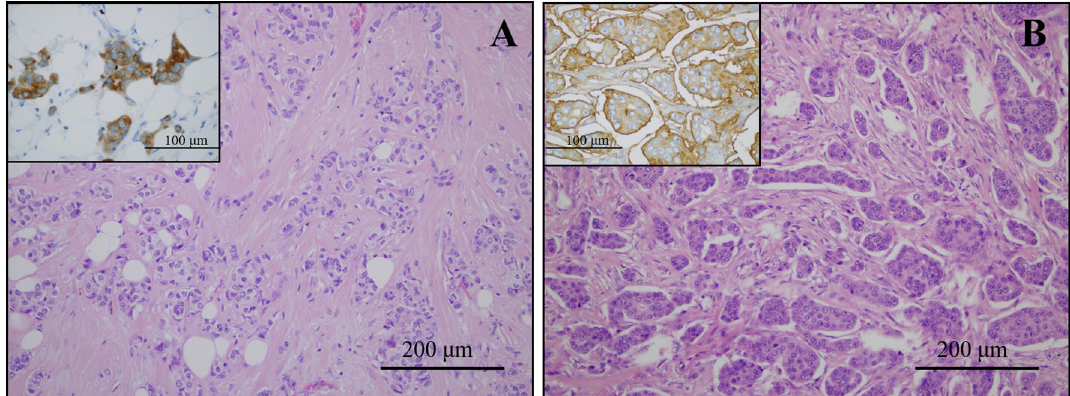
Figure 1. Histological characteristics of IBC-NST and IMPC tumors. Microscopic appearance of IBC-NST tumors ( A ) (H&E stain, ×20). Insert shows membranous/cytoplasmic positivity with EMA antibody